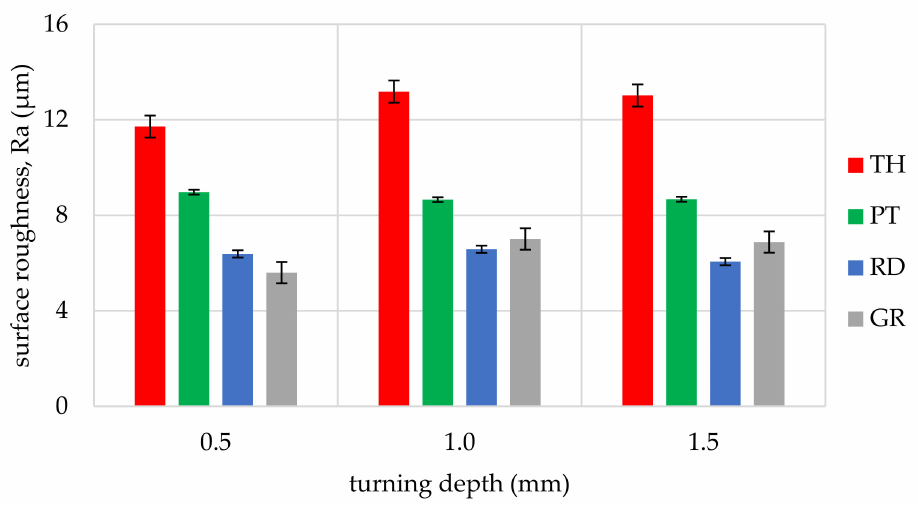
Figure 11. Influence of turning depth and type of cutting insert on surface roughness of Pinewood, Pinus silvestris (PW). Table 2. The R a values obtained in the tests (with standard error value in the brackets) depend on the type of insert and wood